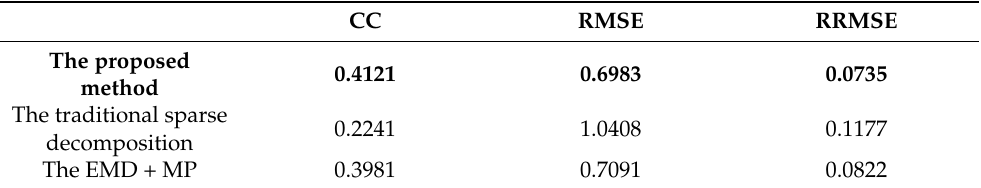
Table 2. The statistical indicators of the extraction results of the three methods.